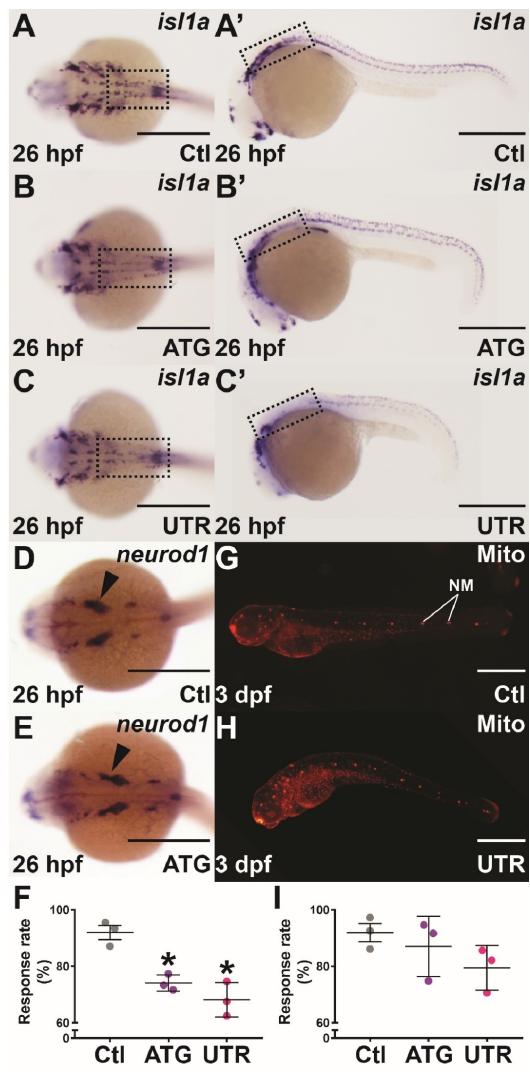
Figure 4. Mechanosensory analysis in socs4a knockdown embryos. Embryos injected with Ctl ( A , A’ , D , G ), ATG ( B , B’ , E ) or UTR ( C , C’ , H ) MO were subjected to WISH with isl1a ( A – C’ ) or neurod1 ( D , E ) at 26 hpf, or Mitotracker red (Mito) staining at 3 dpf ( G , H ) and imaged dorsally ( A – E ) and